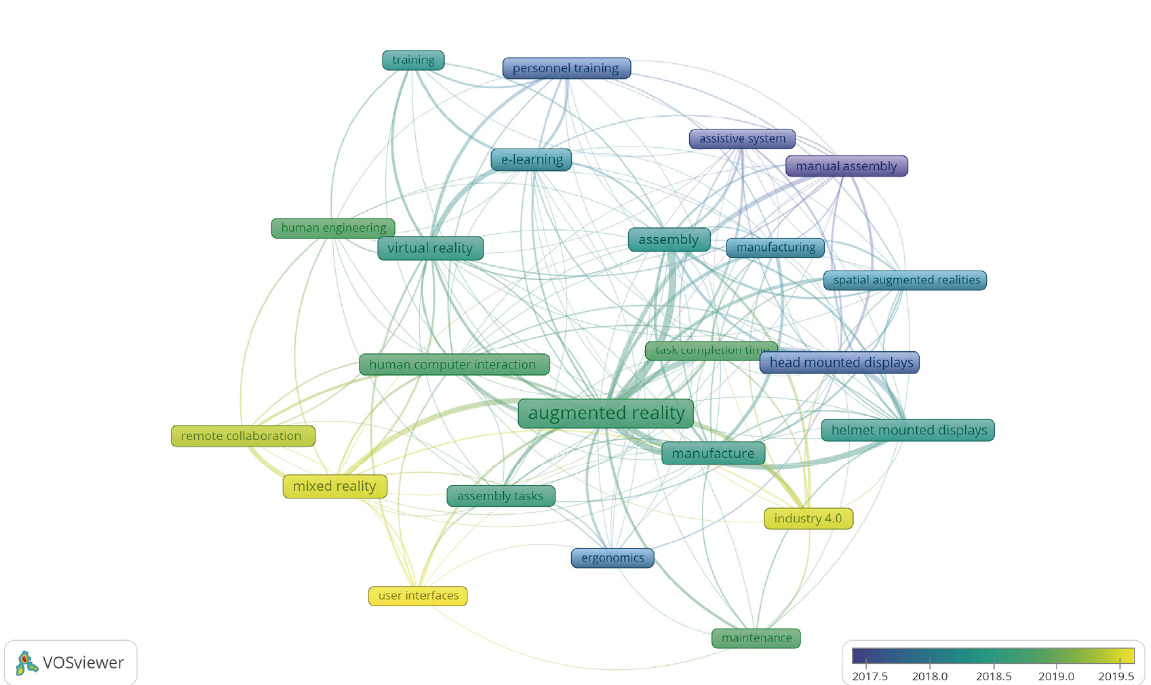
Figure 3. Keywords co-occurrence trend using